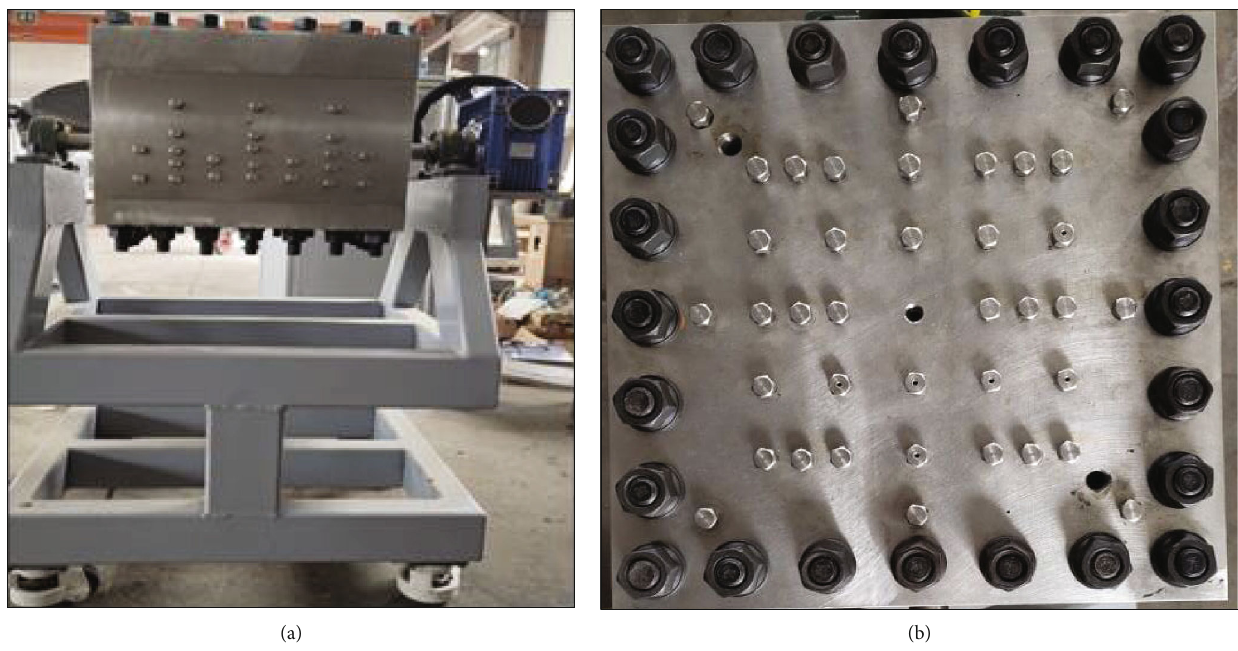
Figure 9: The 3D physical experiment device. (a) External structure. (b) Temperature measuring points.